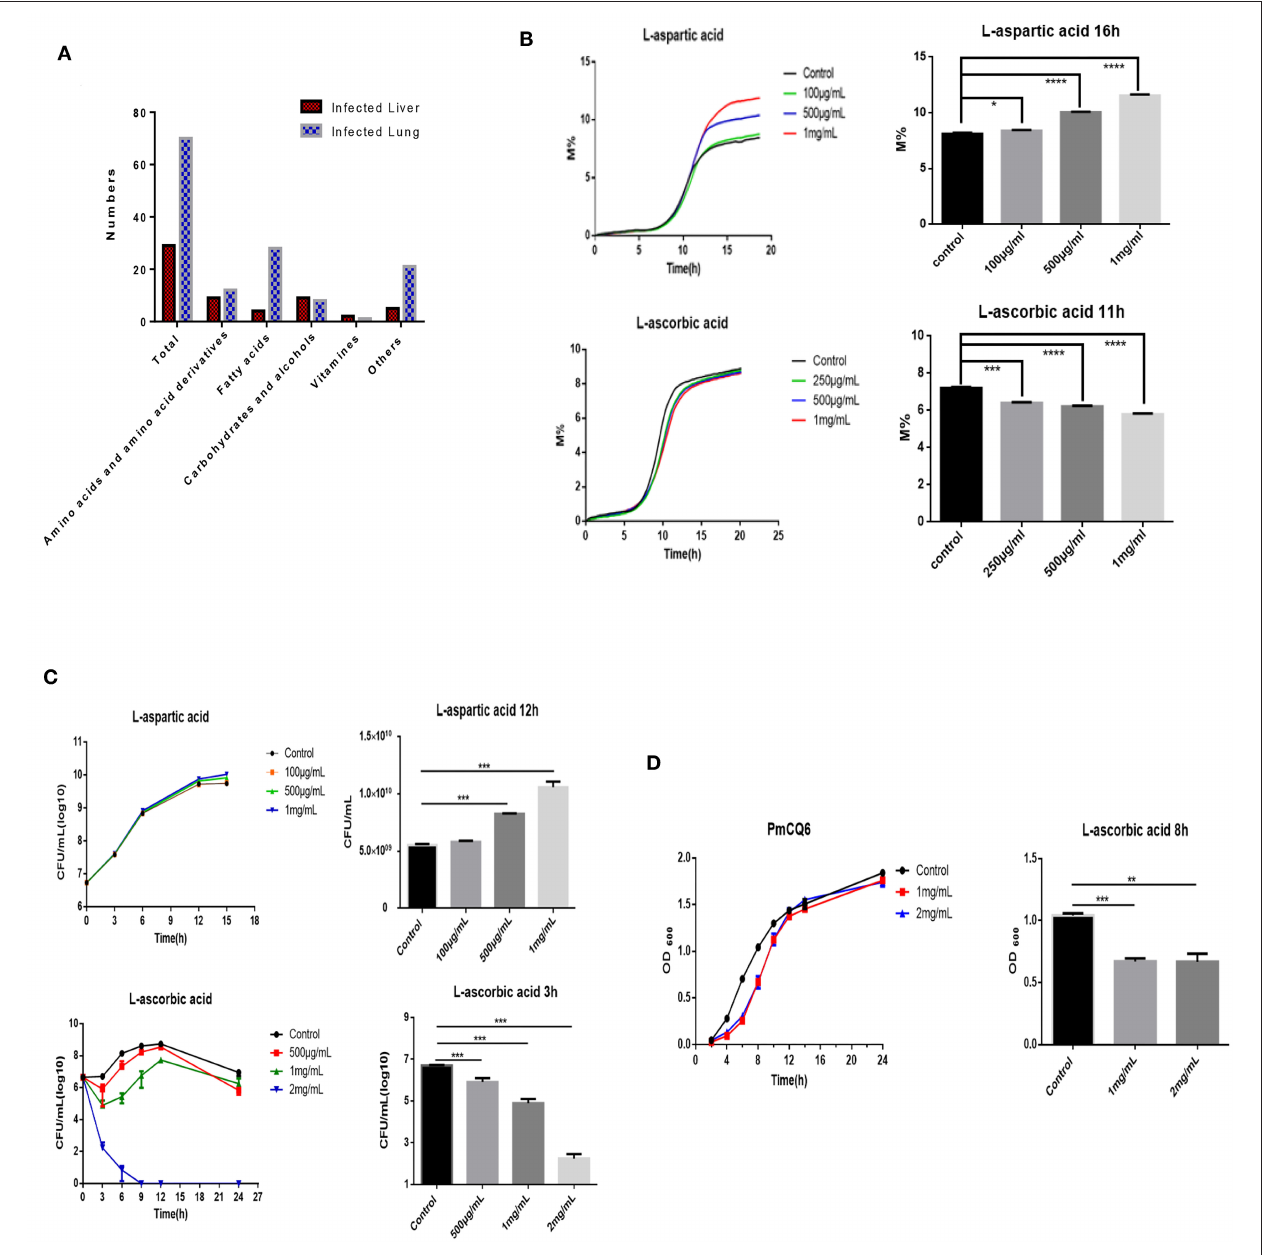
FIGURE 2 | AA and Asp influenced bovine P. multocida growth in vitro . (A) The differently expressed metabolites of the mouse infected lung and liver. These mice were intranasally infected with 10 4 log-phase PmCQ2 for 16h and a total of eight mice were analyzed. (B) PmCQ2 impedance curves under different doses of AA or Asp supplementation. (C) PmCQ2 growth curves under different doses of AA or Asp supplementation. (D) PmCQ6 growth curves under different doses of AA. All experiments own three repeats for each group. *, **, ***, and **** represent P < 0.05, P < 0.01, P < 0.001, and P < 0.0001,